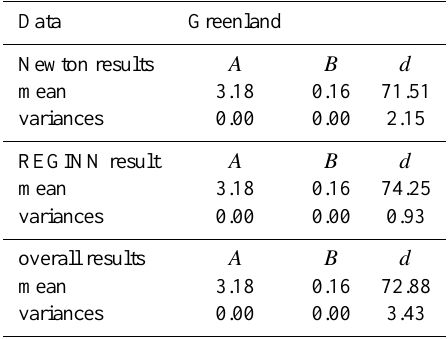
Table 3. Results of the inversion of the data set west of Greenland. Both algorithms give similar reconstruction values with small vari-